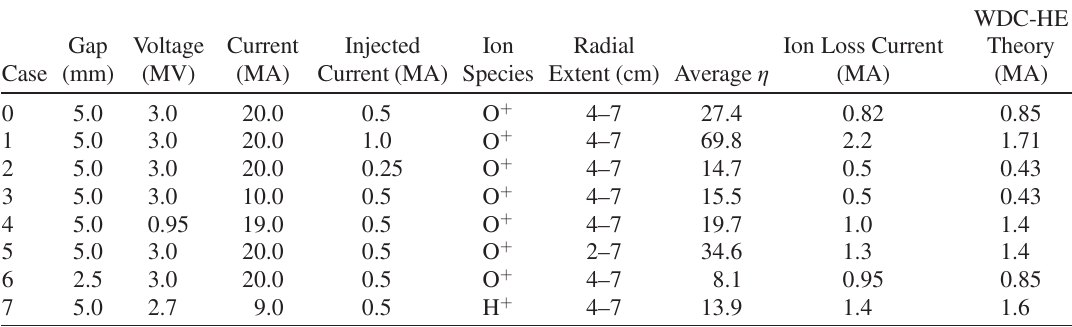
TABLE I. Summary of the single ion species, 2D EM simulation results.